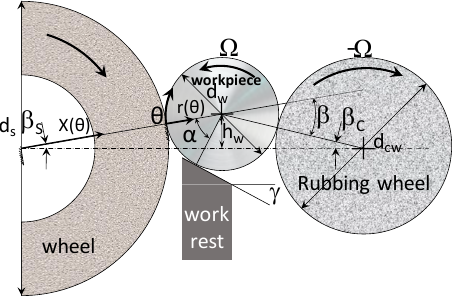
Fig. 1. Centerless grinding